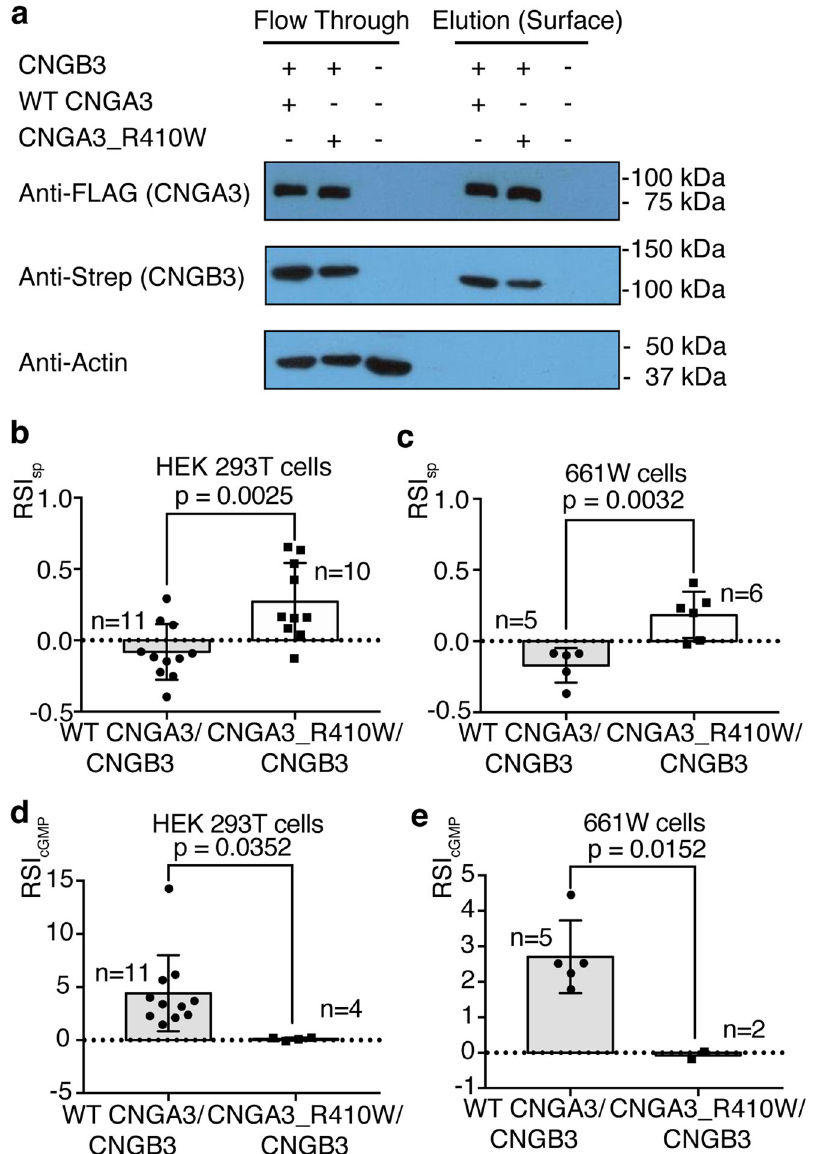
Fig. 5 Spontaneous activity of surface mutant CNGA3/CNGB3 channels revealed by Ca2 + imaging. a Western blot with the indicated antibodies of transiently expressed WT and mutant CNGA3 and CNGB3 subunits from one preparation of surface biotinylation. The elution fraction was collected from the neutravidin-agarose beads and represents cell surface proteins. Flow through contained all the proteins that did not bind to the neutravidin-agarose beads, including cytoplasmic and organellar proteins. Anti-actin was used as a loading control and an indicator of cell integrity and biotinylation speci fi city. Similar results were observed in two other preparations. b , c Ca 2 + imaging of HEK 293T and 661W cells transfected with WT and mutant human CNGA3/ CNGB3 channels. The cells were fi rst incubated with 2 mM CaCl 2 and 100 µ M diltiazem (DTZ) without cGMP. Then CaCl 2 and DTZ were washed off and the cells were treated with 2 mM CaCl 2 . The normalized fl uorescent signal increase upon switching from Ca 2 + + DTZ to Ca 2 + -only is de fi ned as spontaneous Relative Signal Increase (RSI sp ). Each point represents one well of cells from one of four to six different cultures. d , e Ca 2 + imaging of HEK 293T and 661W cells transfected with the indicated channels, treated with 100 μ M CPT-cGMP. The normalized fl uorescent signal increase upon switching from 2 mM CaCl 2 to 2 mM CaCl 2 and 100 μ M CPT-cGMP is de fi ned as RSI cGMP . Each point represents one well of cells from one of four to six different cultures. Data are presented as mean ± SD. Statistical signi fi cance was evaluated with Student ’ s t strategies for patients carrying particular mutations that cause visual disorders.